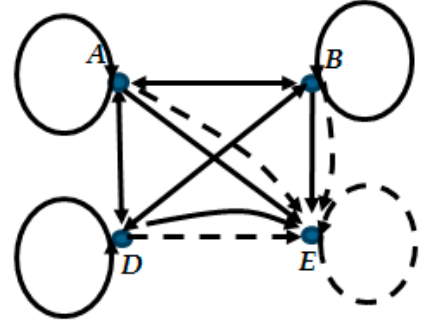
Figure 4. A four-person good puzzle with maximum number of edges.